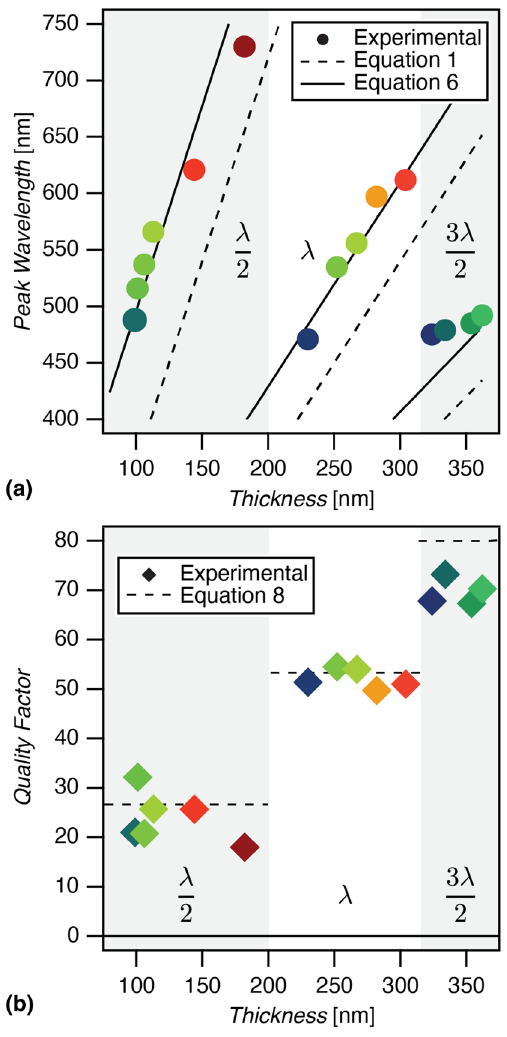
Figure 3. ( a ) Peak emission wavelength vs. thickness. Dashed line represents the ideal classical theory Eq. (1) 1.8 , and solid lines include penetration depth of 40 nm and 27 nm in the with assumed index of refraction n = Ag and Al using Eq. (6). ( b ) Quality factor versus microcavity thickness. Dashed lines are calculated using Eq. R (8) assuming R 1 2 ≈ 0.8 (see Supplementary Figure ×